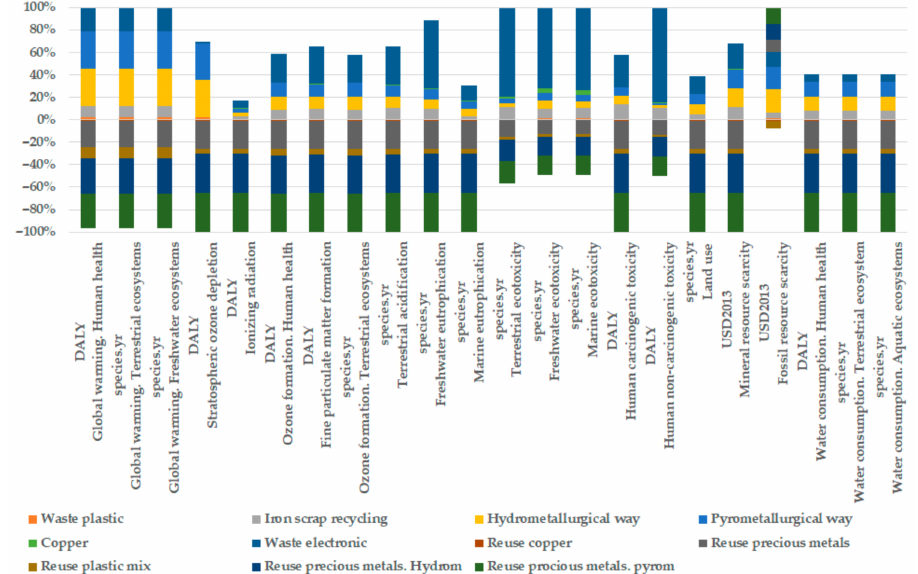
Figure 5. Characterization of the end-of-life phase for LFP (ReCiPe 2016 method-Endpoint (H)). Table 5. Carbon footprint of 1 MWh of stored energy in the two